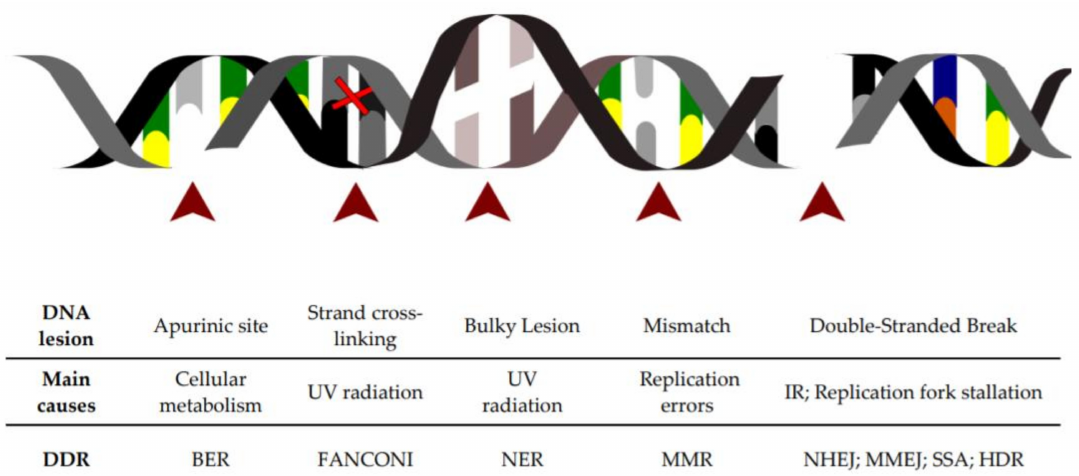
Figure 1. Schematic of the major DNA lesions experienced by cellular genomic DNA: The table below indicates the type of DNA lesion depicted in the figure above, its leading cause and the DNA repair pathway engaged for its